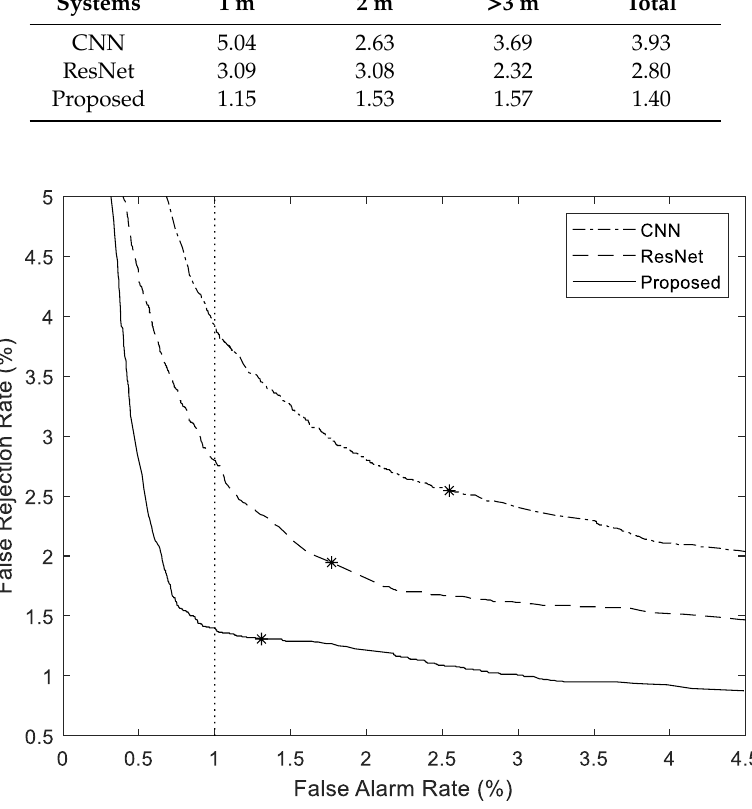
Figure7. Figure 7. ROC (receiver operating characteristic) curves of the baseline systems and the proposed system.